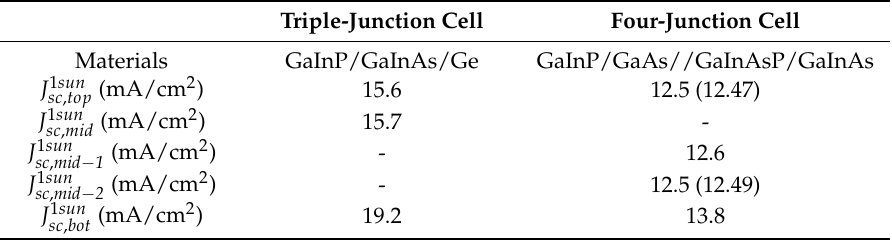
Table 2. Description of both solar cells. The short-circuit density values result from ray tracing